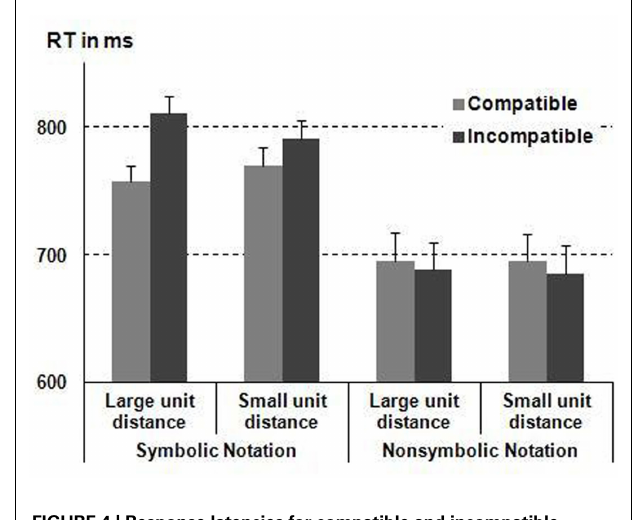
FIGURE 3 | Schematic illustration of an example stimulus of the structured non-symbolic number pair. Participants had to indicate the larger numerosity.